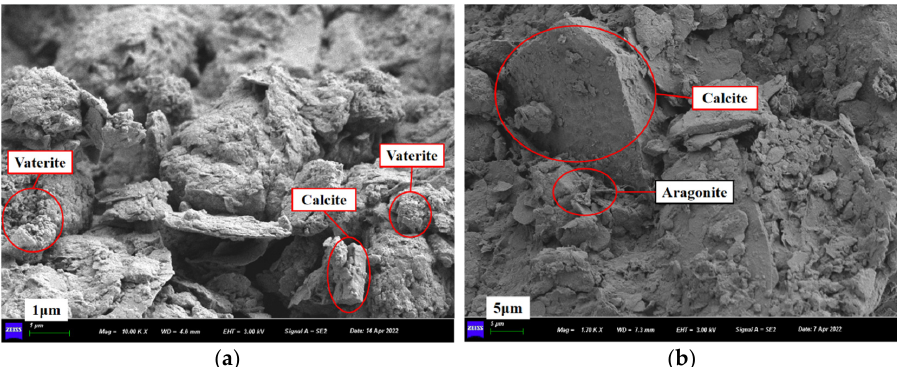
Figure 13. Different CaCO 3 crystal morphology in PMMRS: ( a ) vaterite and calcite, ( b ) calcite and aragonite.